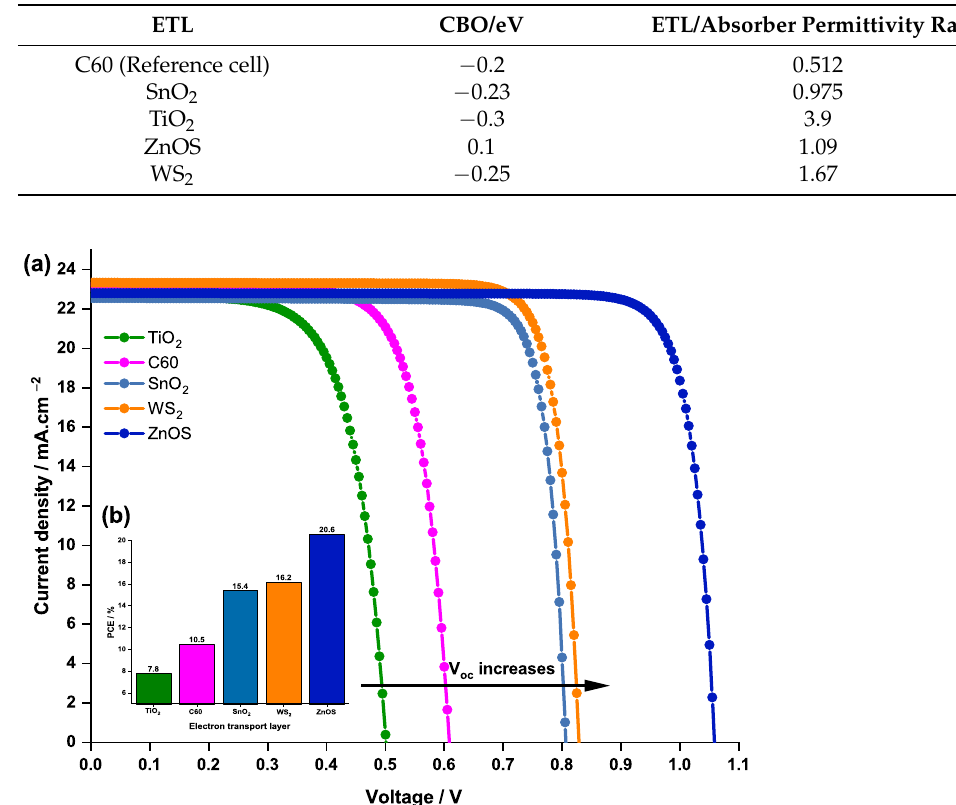
Table 7. Conducting band offset and ETL/absorber permittivity ratio for the ETL materials.